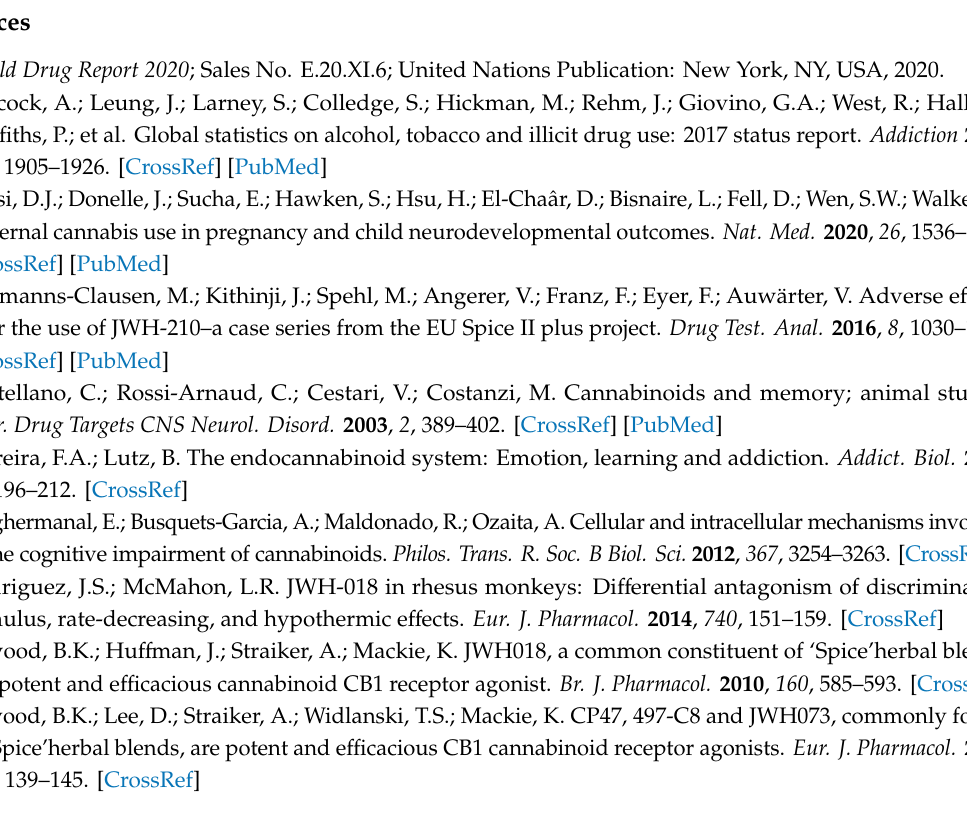
Supplementary Materials: The following are available online. Synthesis and characterization of synthetic cannabinoids, Table S1: CB1R-binding a ffi nity raw data for 15 synthetic cannabinoids, Table S2: List of descriptors used for QSAR models, Table S3: Statistical analysis of MLR models, Figure S1: Q-Q plots of the residuals from MLR model 31 showing a normal distribution, Figure S2: Q-Q plots of the residuals from PLSR model showing a normal distribution, Figure S3: Y-Randomization analysis of the generated PLSR model, Table S4: CB1R-binding a ffi nity (pK i ) of JWH-series compounds predicted by the PLSR